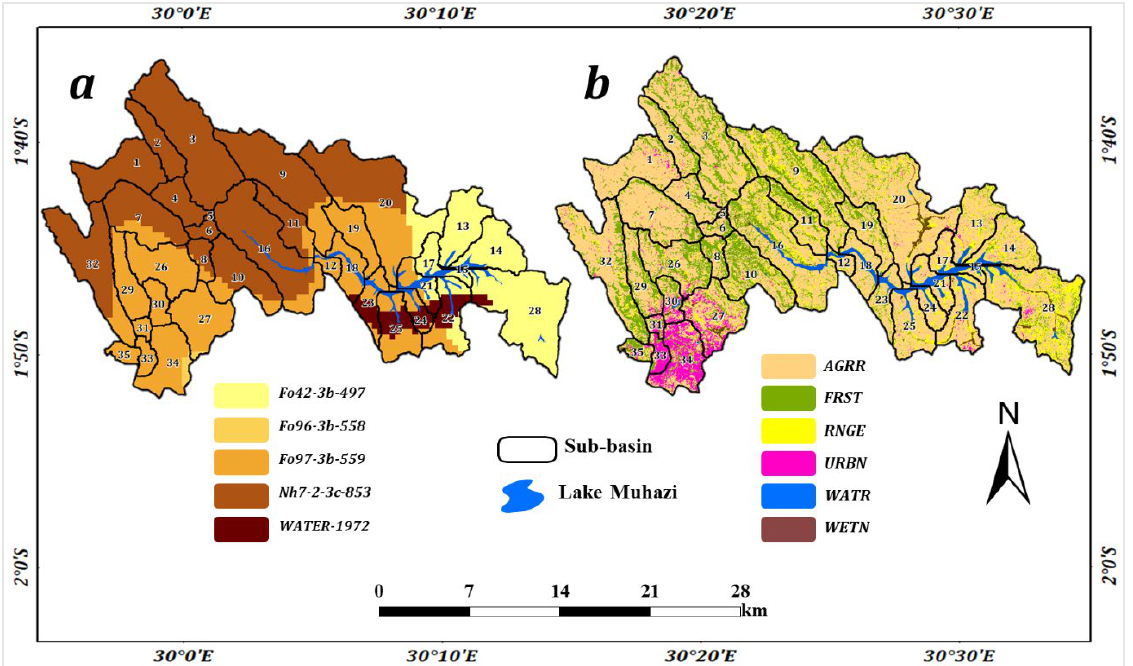
Figure 2. ( a ) Soil attributes and ( b ) land cover land use of the Nyabugogo catchment.